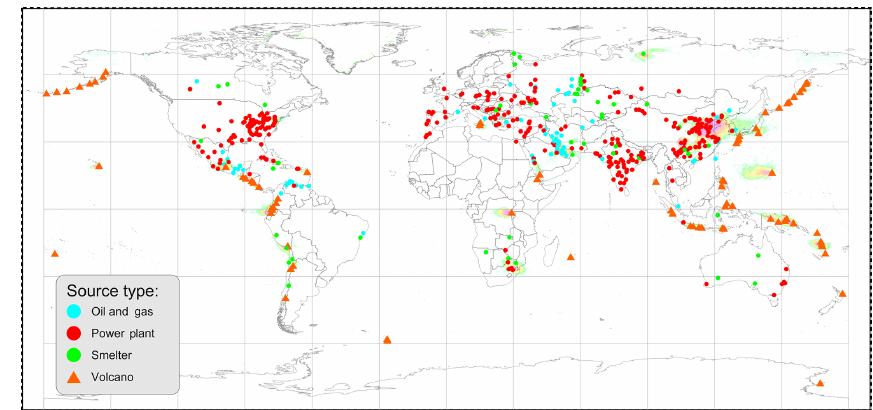
Figure 10. Geographic distribution of the OMI-based SO 2 sources in the catalogue. At present, there are 491 sites based on 2005–2007 data (297 power plants, 53 smelters, 65 oil- and gas-industry-related sources, and 76